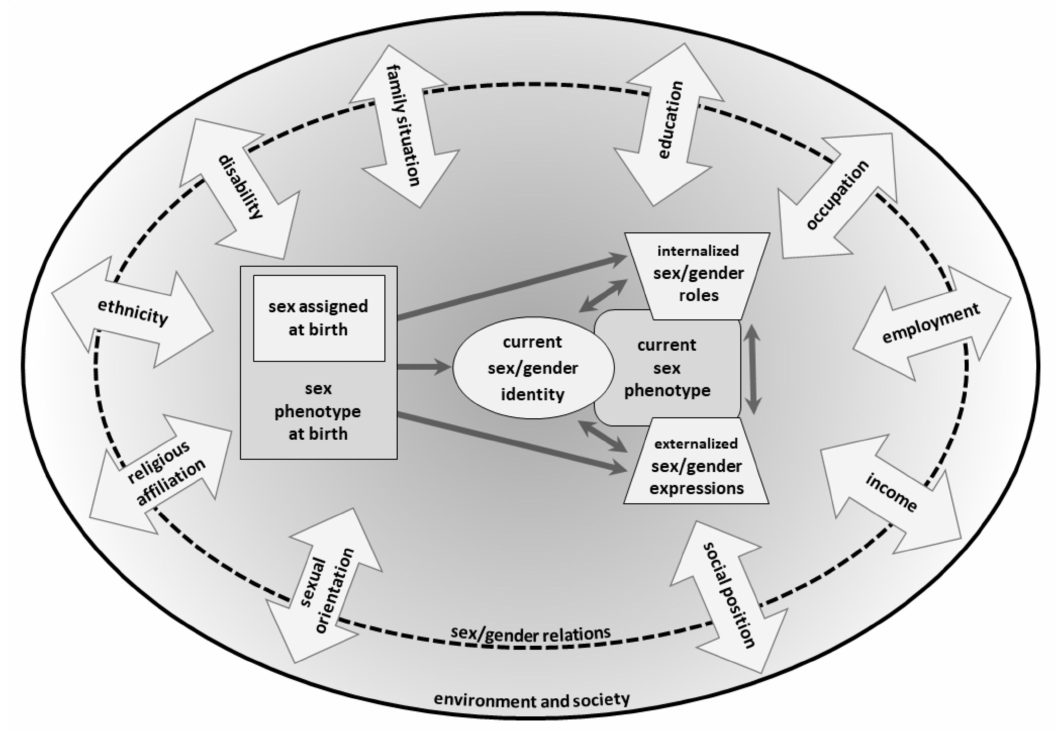
Figure 1. The INGER multidimensional sex/gender concept with its intersectional